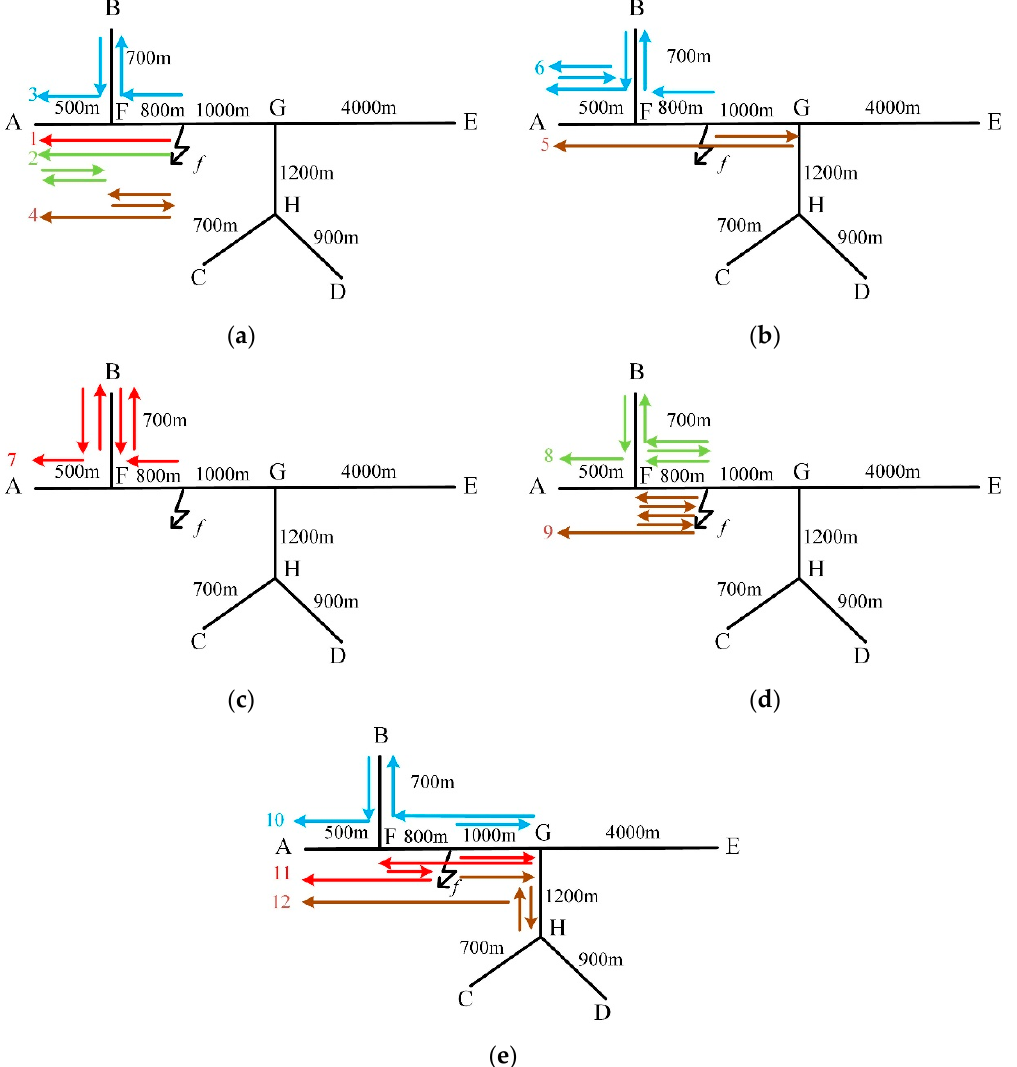
Figure 1. Propagation paths of the fault-originated traveling waves, ( a ) path 1–4, ( b ) path 5–6, ( c ) path 7, ( d ) path 8–9, and ( e ) path 10–12.